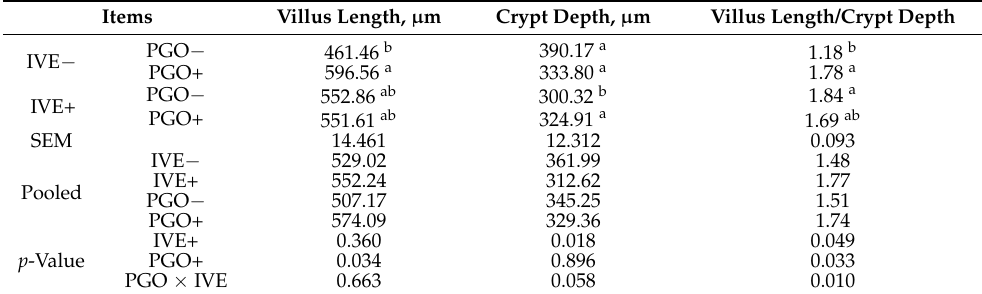
Figure 1. Effect of probiotics with added glucose oxidase (PGO) and Illicium verum extracts (IVE) on the jejunal histomorphology of weaned piglets. Treatment 1 was fed with basal diet (IVE-PGO−, ( A1 , A2 )), and treatments 2, 3, and 4 were fed the basal diet supplemented with 1000 mg/kg PGO (IVE-PGO+, ( B1 , B2 )), 500 mg/kg IVE (IVE + PGO−, ( C1 , C2 )), and 500 mg/kg IVE + 1000 mg/kg PGO (IVE + PGO+, ( D1 , D2 )), respectively. Table 5. Effect of probiotics with added glucose oxidase (PGO) and Illicium verum extracts (IVE) on the jejunal villi and crypt depth of weaned piglets 1 . Villus Length/Crypt Items Villus Length, μm Crypt Depth, μm